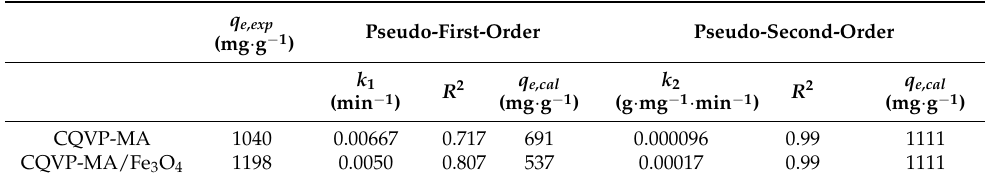
Table 3. Kinetic parameters of pseudo-first- and pseudo-second-order models for the adsorption of CBB dye onto CQVP/MA and CQVP/MA-Fe 3 O 4 .